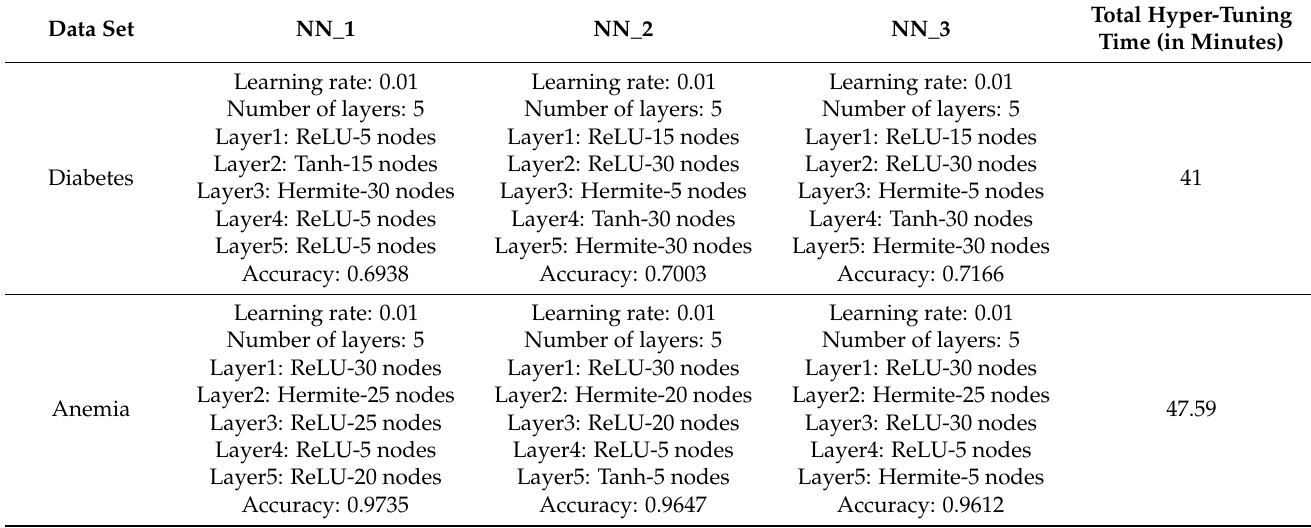
Table 5. (First Experiment) Optimal hyperparameter values, classification (i.e., validation) accuracy evaluated on the testing data, and total time needed to perform the hyperparameter optimization (i.e., total hyper-tuning time) obtained by the three best neural networks: NN_1, NN_2, and NN_3 (Data sets: diabetes and anemia).